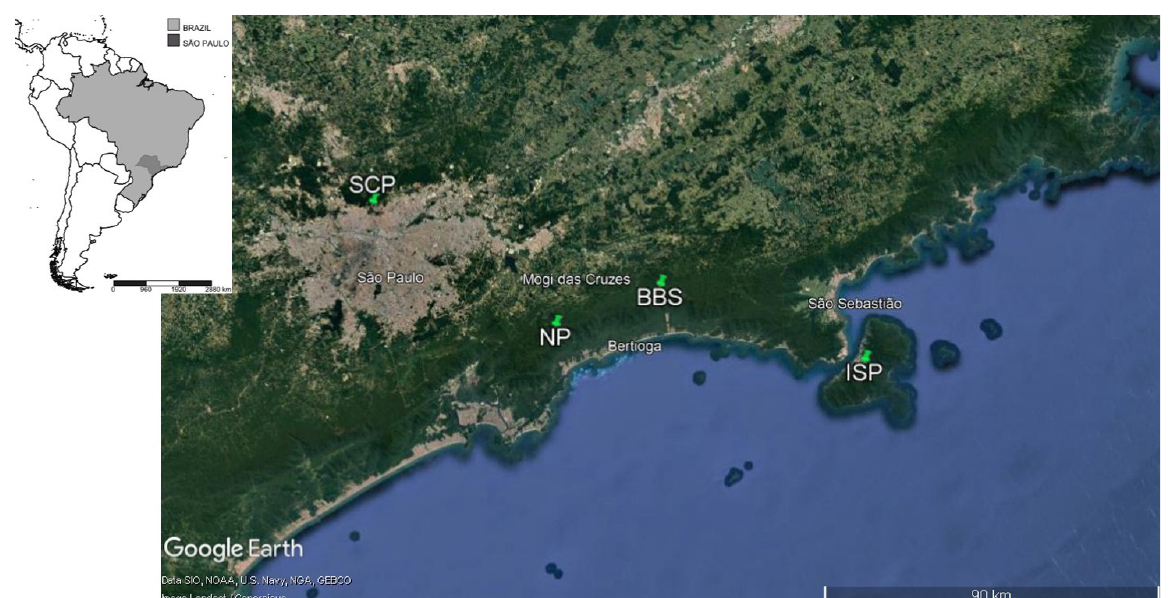
Fig 1 . Main reference cities and study sites in the four protected areas of Atlantic Forest domain, in the state of São Paulo, Brazil. BBS: Boraceia Biological Station; NP: Neblinas Park; ISP: Ilhabela State Park; SCP: Serra da Cantareira State